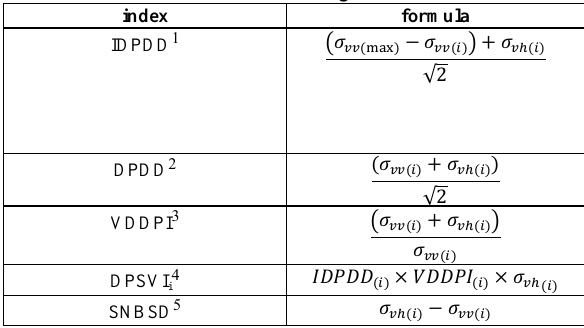
Table 1: Dual Polarized vegetation indexes index formula